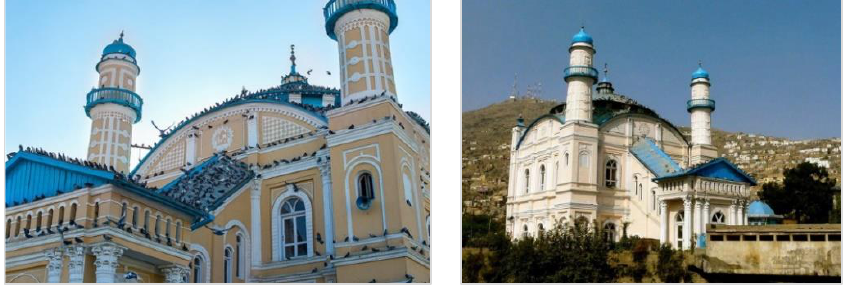
Figure 11 Shah-Do Shamshira Mosque views in Kabul city (AHA, 2011).